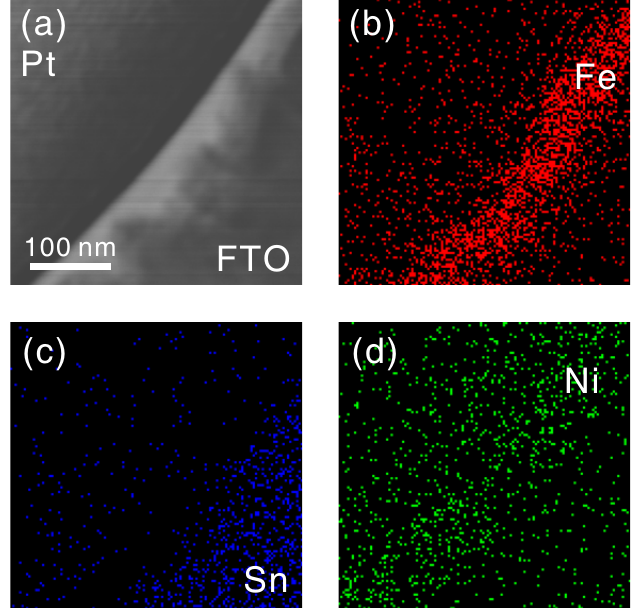
Figure 4. ( a ) cross-sectional TEM image and ( b – d ) cross-sectional energy-dispersive spectroscopy (EDS) maps of Fe, Sn, and Ni of Ni x Fe 1 − x O y /hematite photoanode grown with a Ni-to-Fe ratio of 8:2 and an immersion time of 2 min. The sample was coated with Pt for slicing with a focused ion beam prior to the measurements. The sparsely distributed points in the EDS maps are just system background, and only the denser regions indicate actual presence of the